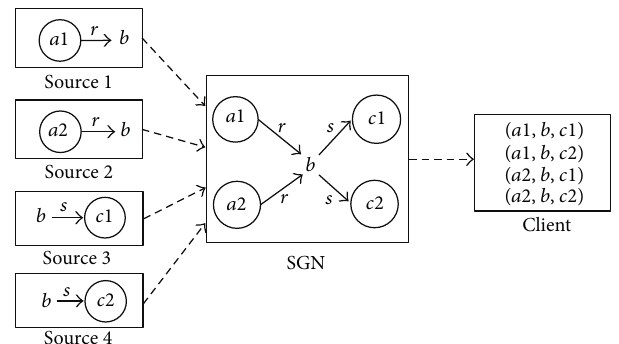
Figure 5: The integration process of the joint composition.